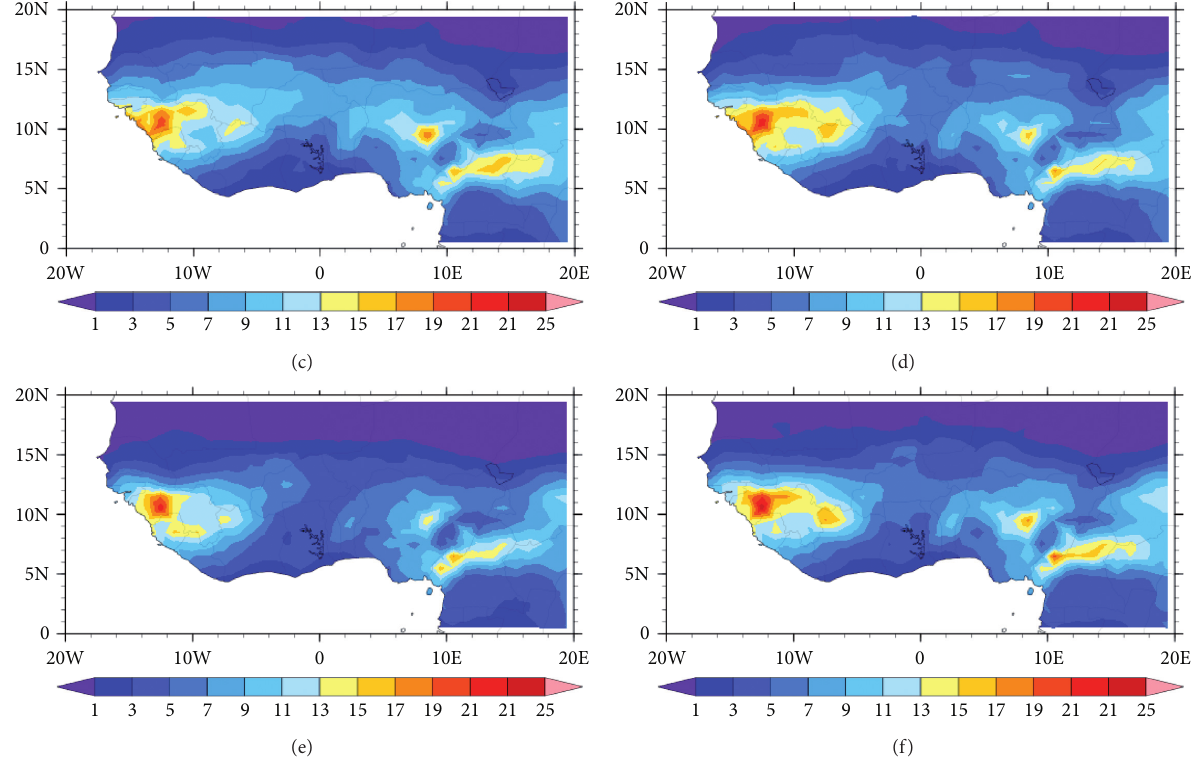
Figure 7: Spatial distribution of average precipitation for July 16 th –Sept 29 th , 2012. (a) TRMM. (b) GPCP. (c) Noah-MP groundwater option. (d) Noah-MP. (e) Noah. (f) CLM4.